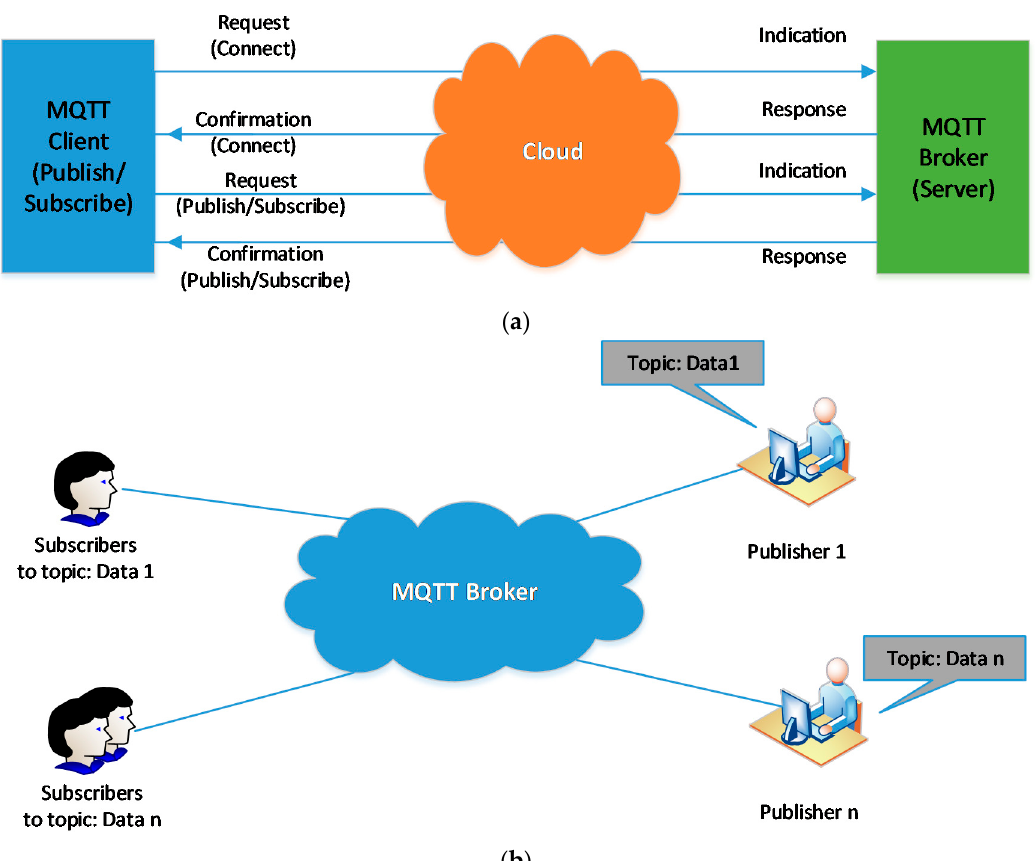
Figure 3. ( a ) MQTT procedure, ( b ) MQTT topic and component.